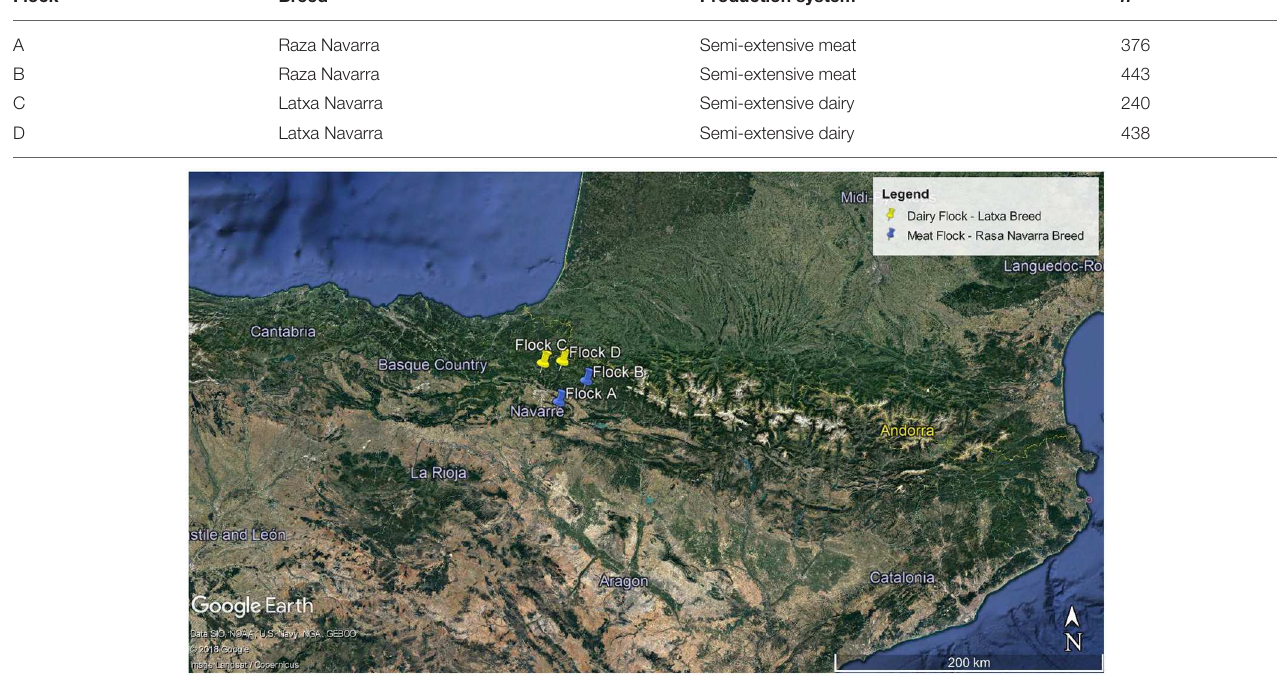
TABLE 1 | Flocks studied: location (map), breed, production system, and total sheep in each flock.